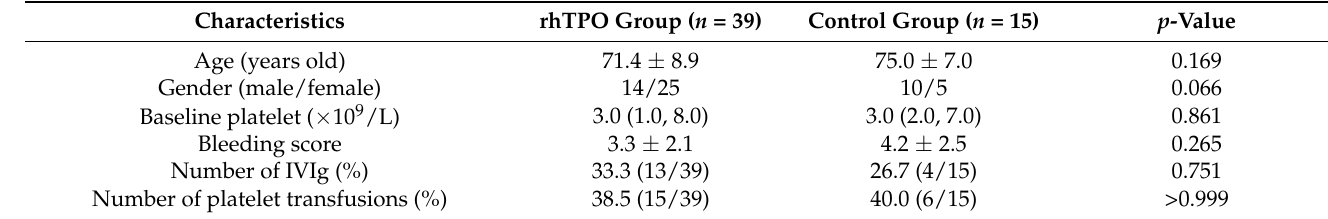
Figure 1. Flowchart of case selection. Table 1. Baseline clinical characteristics.